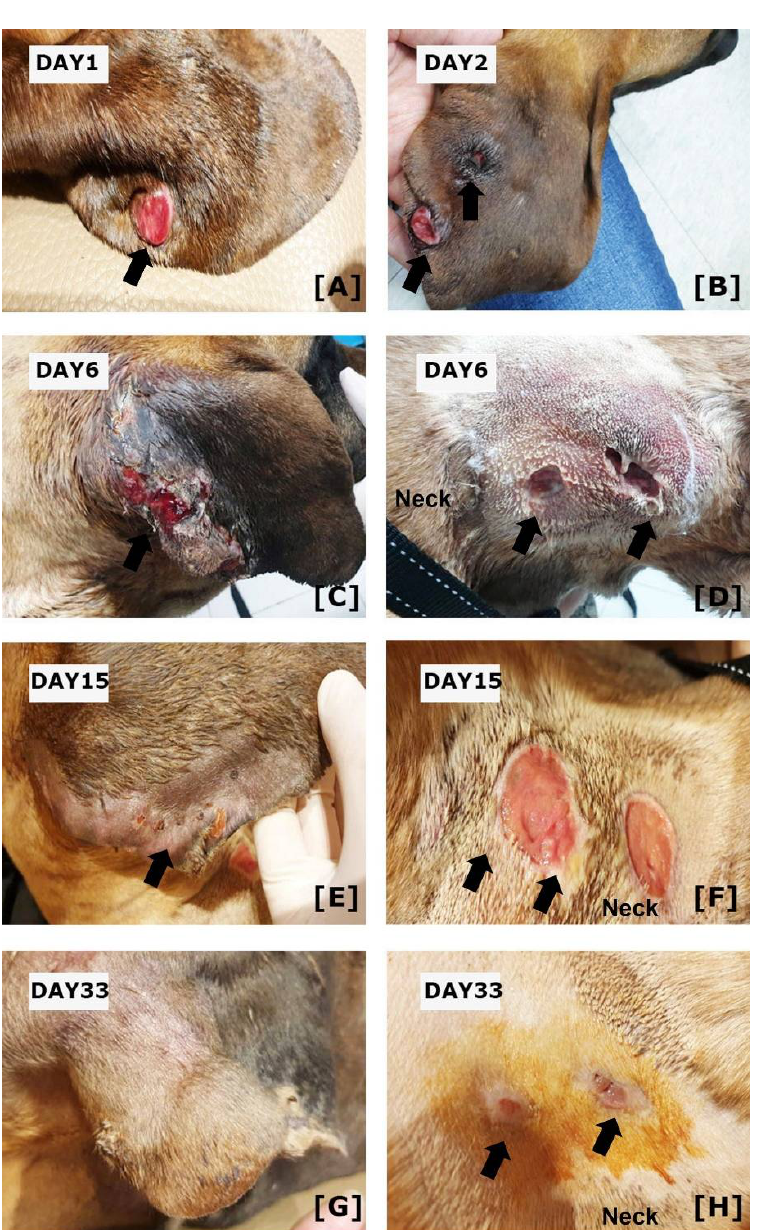
Figure 1. Clinical Features of the Present Case. ( A ) At the initial presentation, ulcerated nodules on the right ear were seen. ( B ) On day two, another lesion with ulceration was observed on the right pinna. ( C ) On day 6, the ulcerative lesions on right pinna have enlarged, ( D ) and ulcerations with fistulous tract were observed on the neck. ( E ) After administration of meropenem and doxycycline, the ulcerations on right pinna have gradually resolved on day 15. ( F ) However, the ulcerations on the neck were still observed. ( G ) On day 33, the skin lesions on the right pinna were resolved and show hair regeneration. ( H ) Ulcerative lesions on the neck also show skin regeneration. Arrows indicate skin lesions.